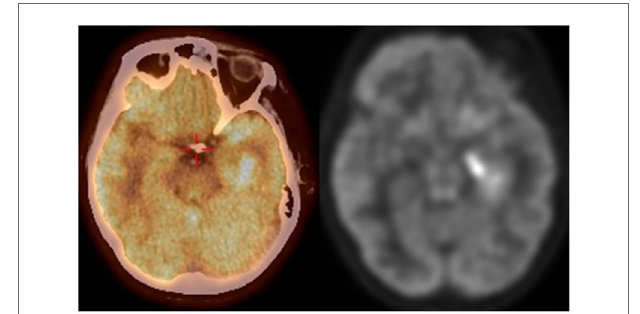
FIGURe 3 | FDG pet Ct scan demonstrating increased FDG uptake in the medial left temporal lobe corresponding to the area of increased FLaIR signal seen on MRI brain